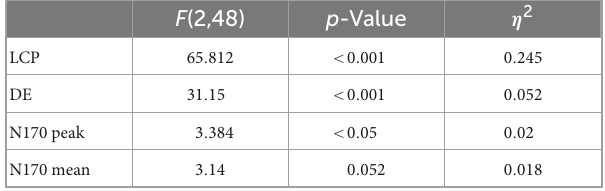
TABLE 1 Results from ANOVA tests.